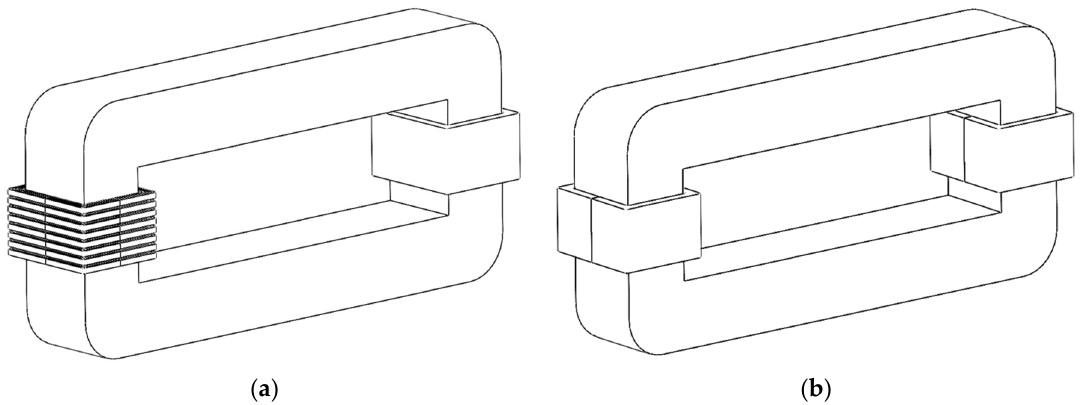
Figure 3. HFT model. ( a ) Interleaved windings; ( b ) Continuous windings.